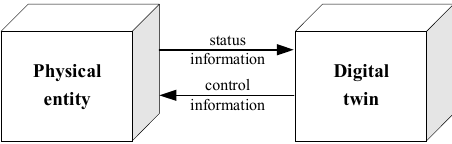
Figure 2. The digital twin model.